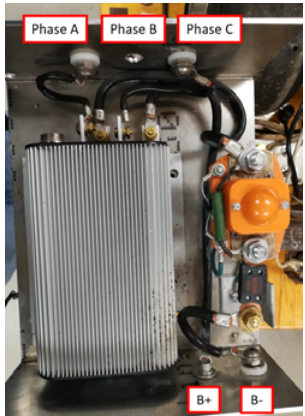
Figure 2. DC/AC inverter used in the hydraulic test bench.